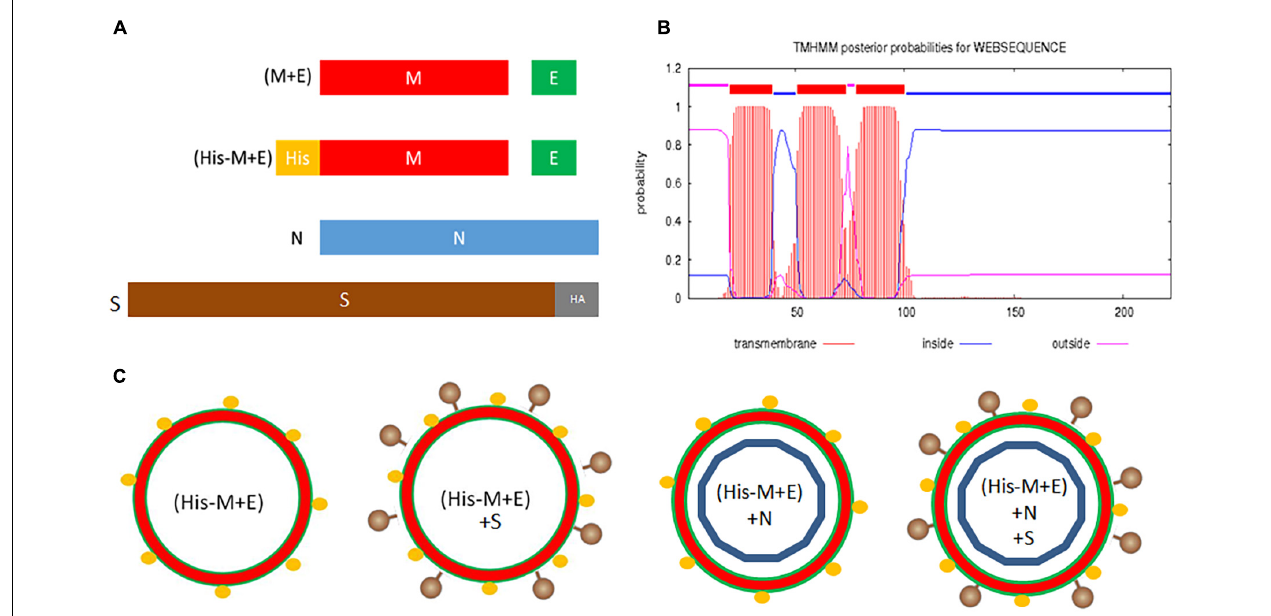
FIGURE 1 | Design of SARS-CoV-2 VLPs. (A) Genetic constructs (pFastBac Dual plasmids) coding for structural proteins of SARS-CoV-2: (M + E) and (His-M + E) are bicistronic vectors; N and S-HA are monocistronic vectors. (B) Predicted topology of the M protein. (C) Possible VLPs resulting from co-infection of insect cells with prepared vectors. Legend: M, membrane protein; E, envelope protein; N, nucleocapsid protein; S, spike protein; SARS-CoV-2, severe acute respiratory syndrome coronavirus 2; VLPs, virus-like particles.